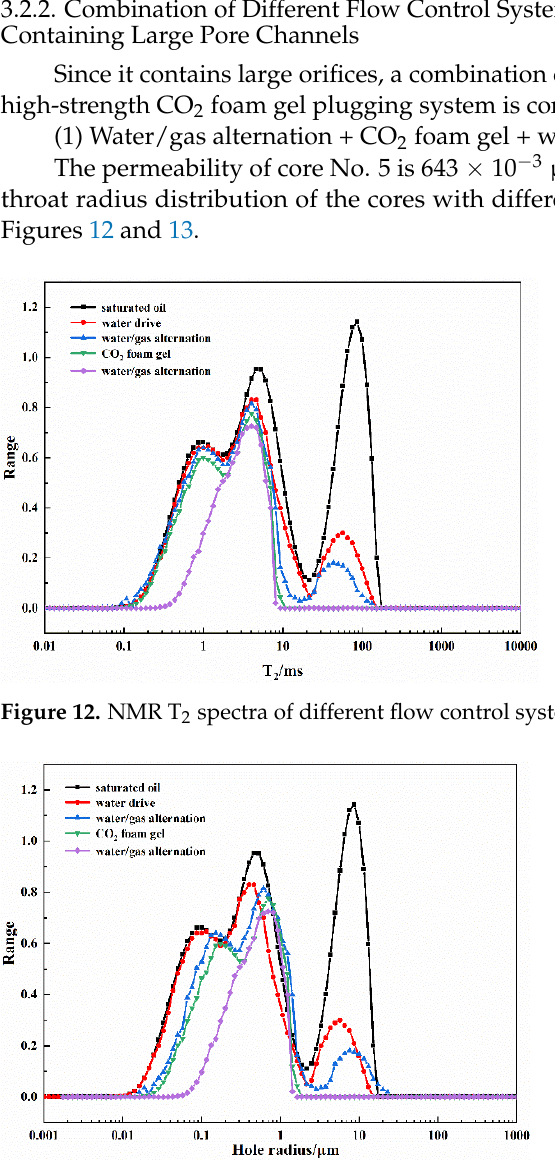
Figure 13. Pore throat radius distribution of different flow control systems in core No. 5.